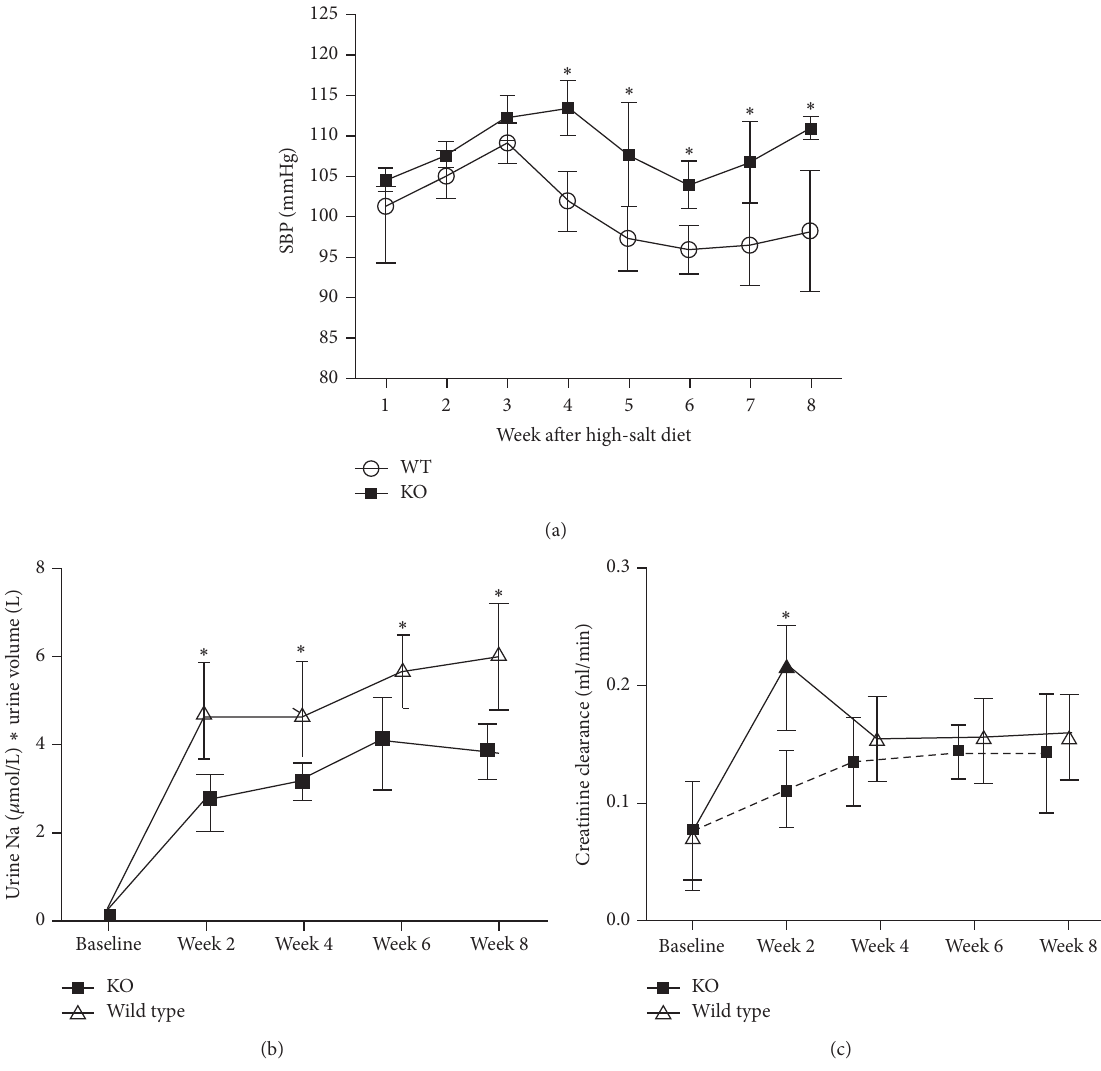
Figure 8: Figure 8 showed comparison of blood pressure (a) and 24-hour urinary sodium excretion (b) and creatinine clearance (c) after high-salt diet between KO mice and WT mice. ∗ 𝑃 < 0.05 versus WT